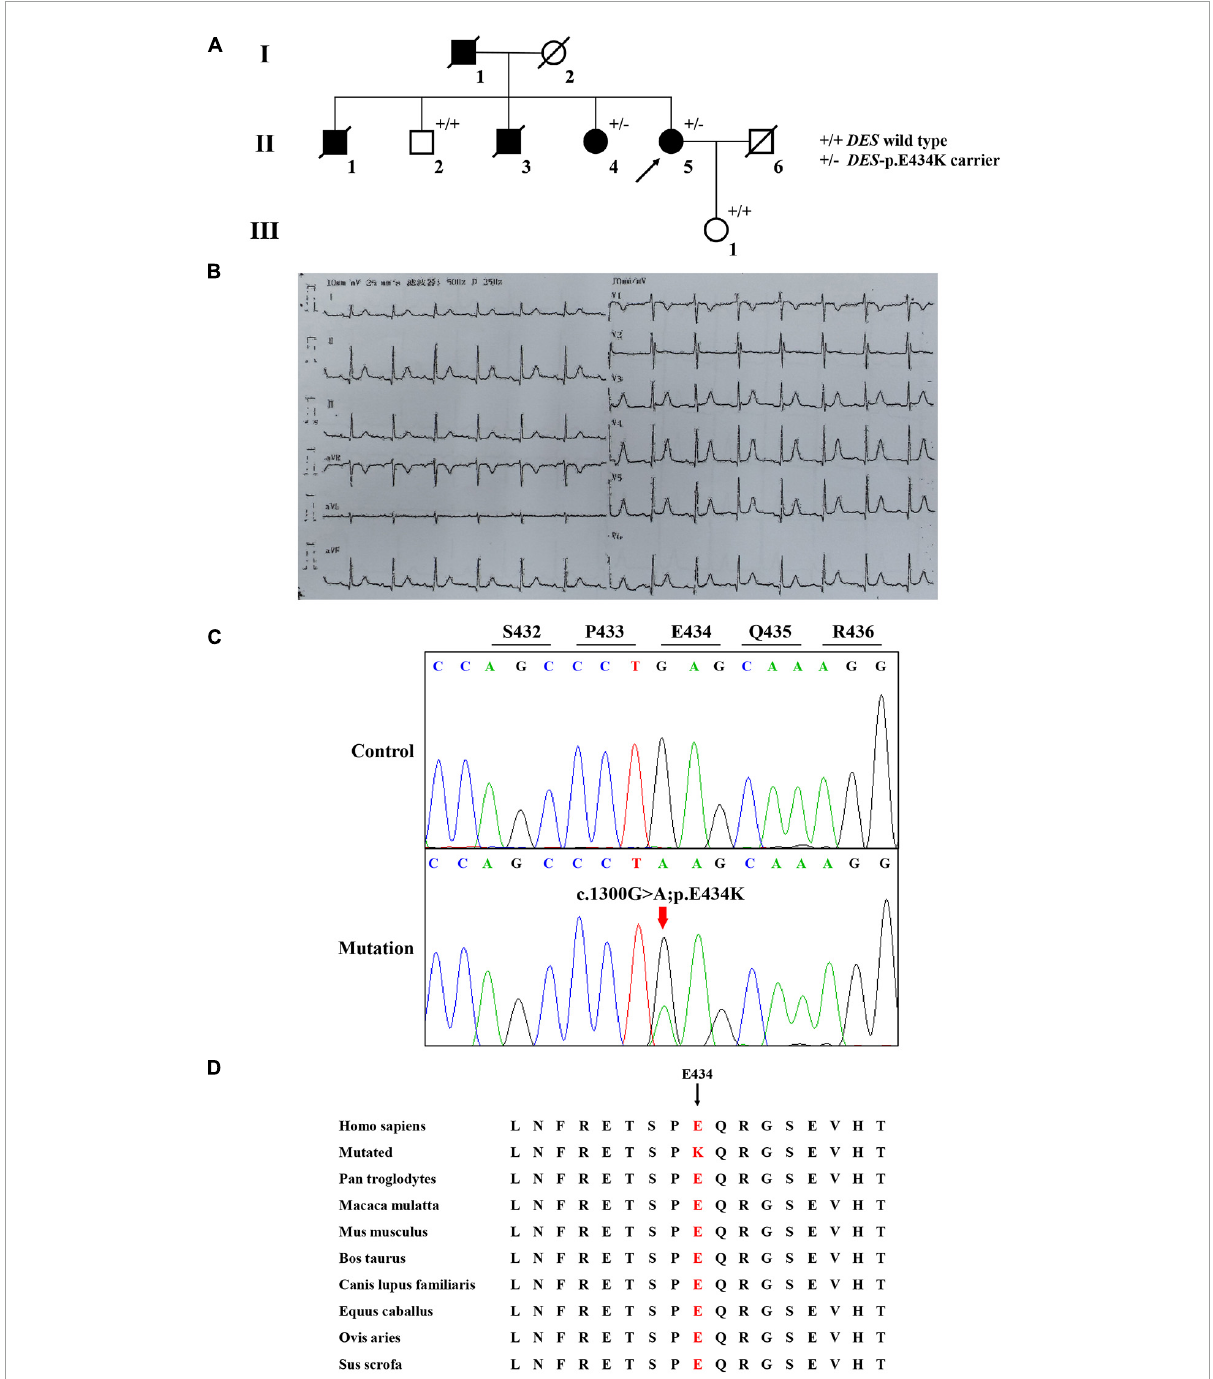
FIGURE1 The clinical and sequencing data of this family. (A) The genealogy of this family. Squares indicate male family members and circles indicate female members. The black symbols represent the clinically affected members. The white symbols represent unaffected and healthy members. The arrow shows the proband. Crossed-out symbols stand for deceased relatives. ± represents heterozygous DES -p. E434K variant. + / + represents a wild type. (B) ECG of the proband. (C) Sanger DNA sequencing chromatogram detected a heterozygous mutation (c.1300G > A; p. E434K) of DES gene in the proband. (D) Alignment of multiple DES protein sequences across species. Letters in red show the E434 site is evolutionarily